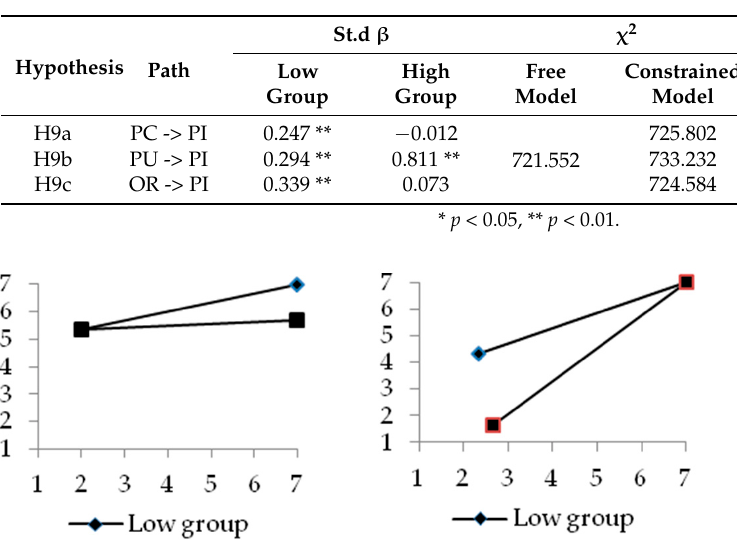
Table 7. Summary of moderating analysis.